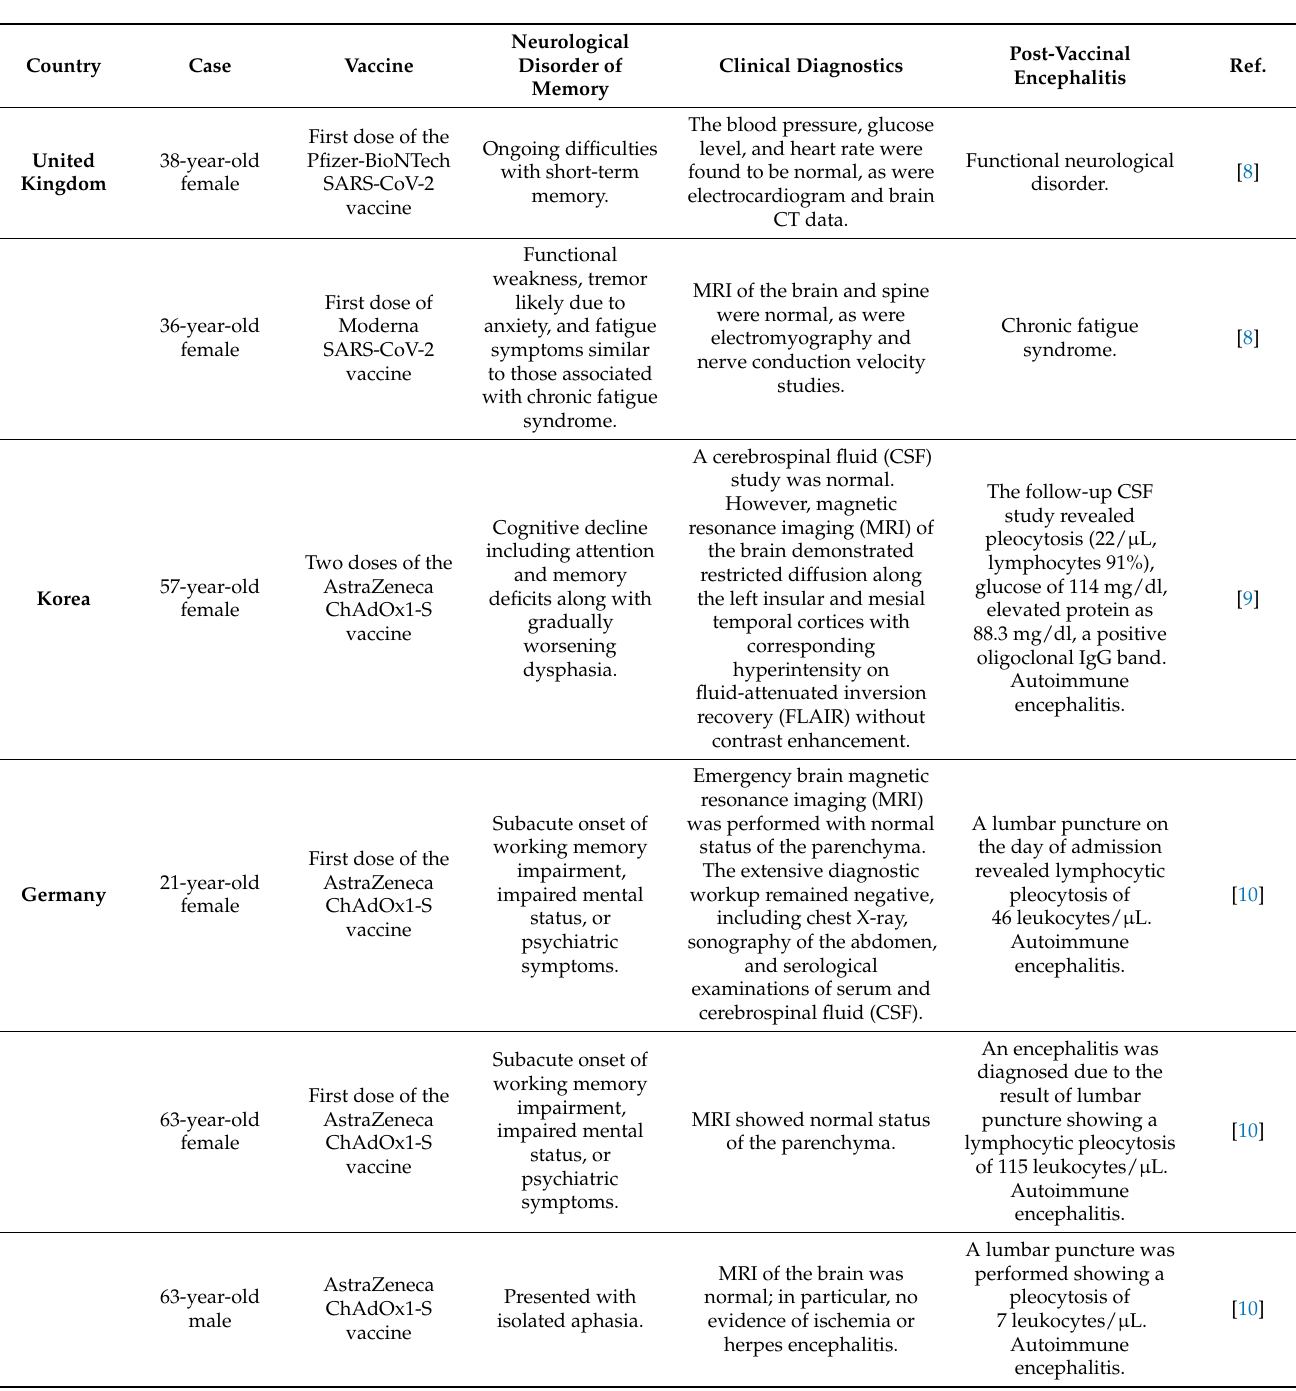
Table 1. List of reviewed studies regarding the neurological disorder of memory and clinical diagnos- tics in patients after COVID-19